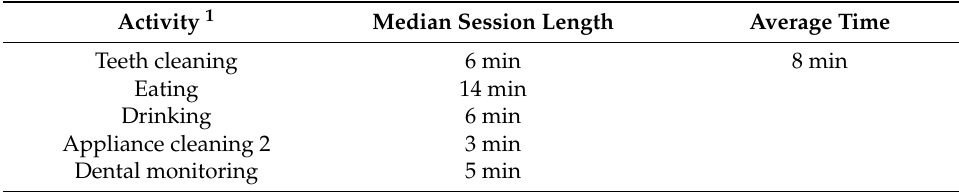
Table 3. Information from statistical data processing of the large set of